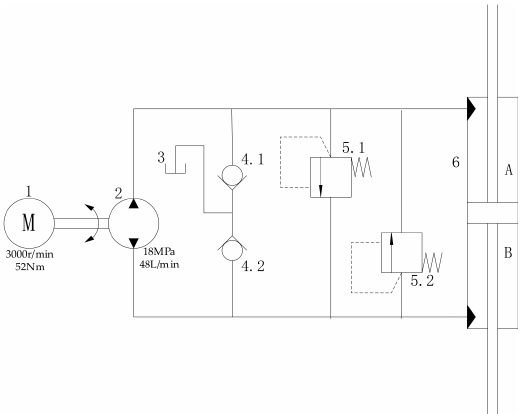
Figure 1. Hydraulic system diagram of electro-hydraulic servo pump control system: 1—servo motor; 2—quantitative pump; 3—hydraulic oil tank; 4—check valves; 5—relief valves; 6—hydraulic